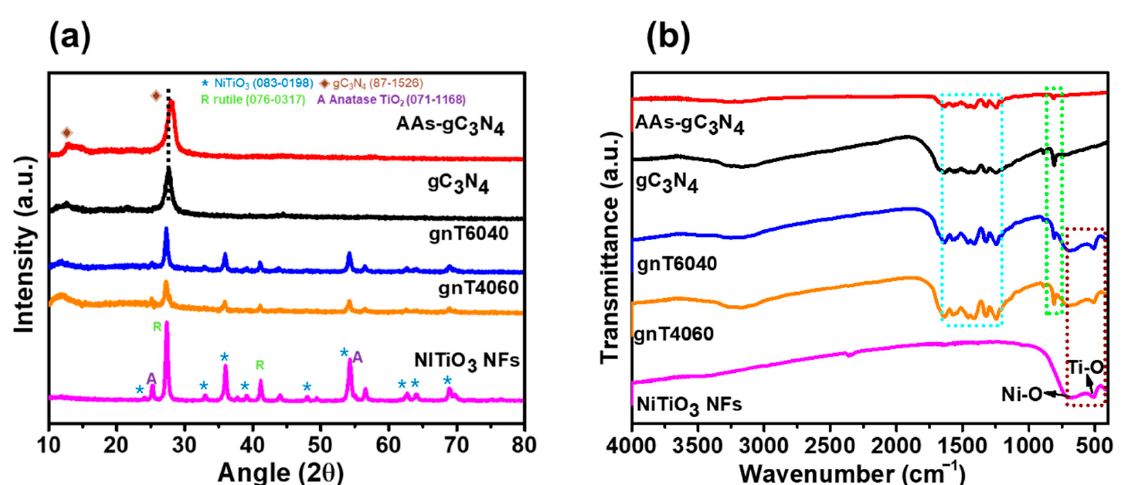
Figure 3. ( a ) X-ray diffraction (XRD) patterns and ( b ) Fourier transform infrared (FTIR) spectra of NiTiO 3 NFs, gC 3 N 4 , AAs-gC 3 N 4, gnT4060, and the gnT6040 hybrid.